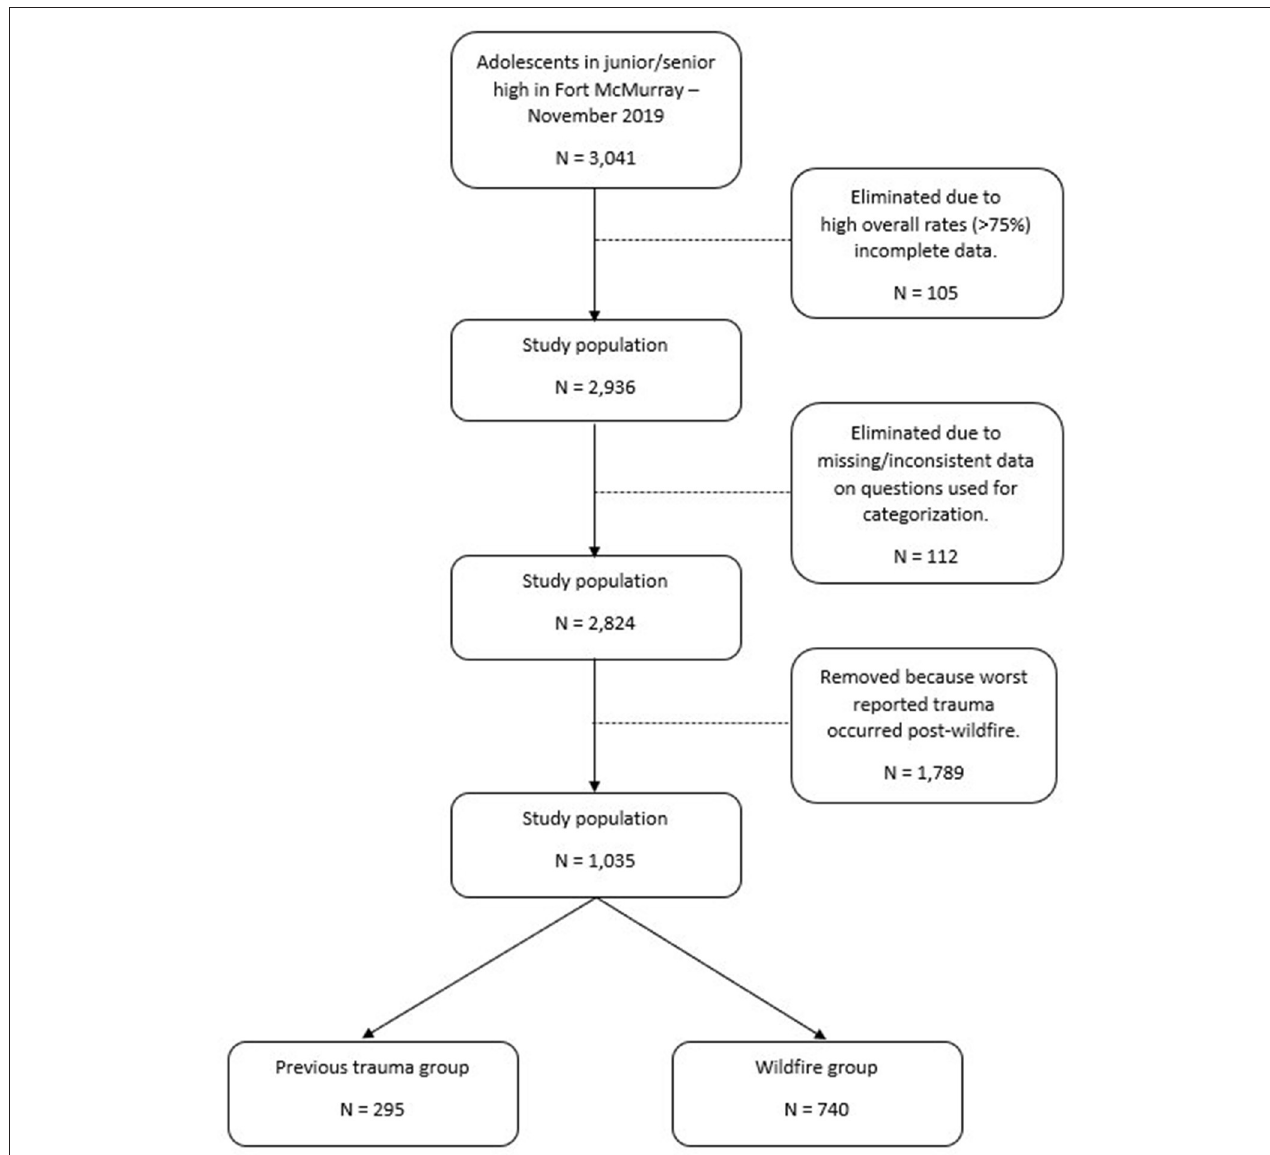
FIGURE 1 | Subject flow diagram illustrating number of individuals in each group.